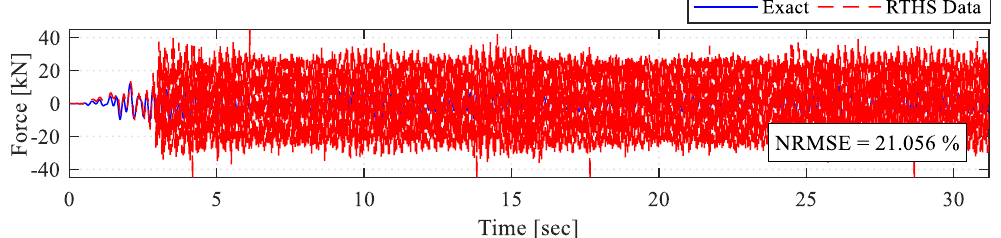
Figure 20. Brace obtained force feedback from Model 1a RTHS test without specimen as compared to the exact analytical solution.